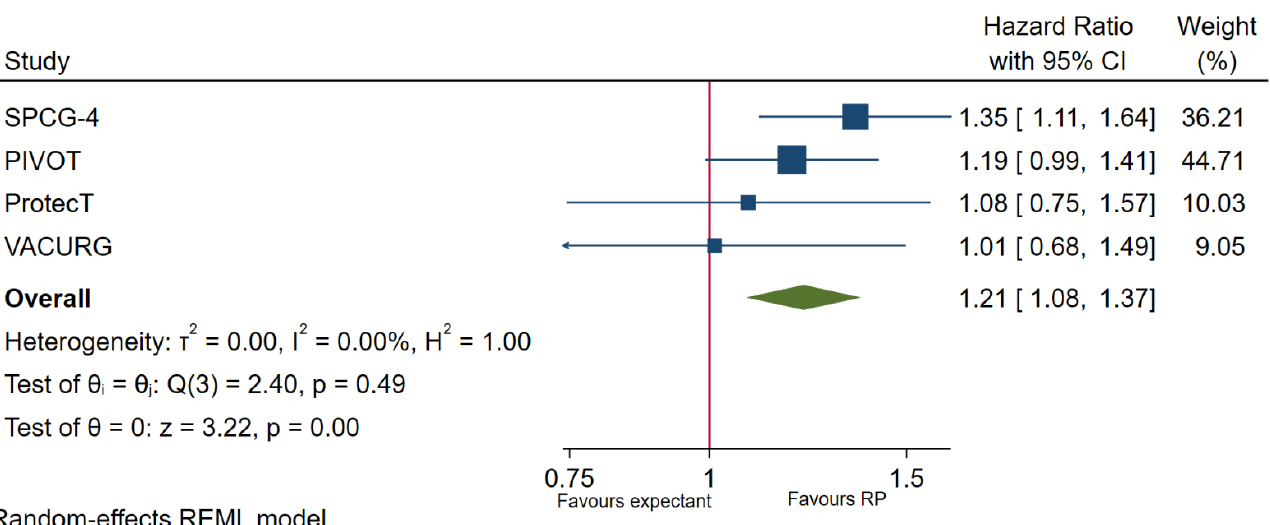
Figure 2. Overall survival in expectant management versus immediate RP.